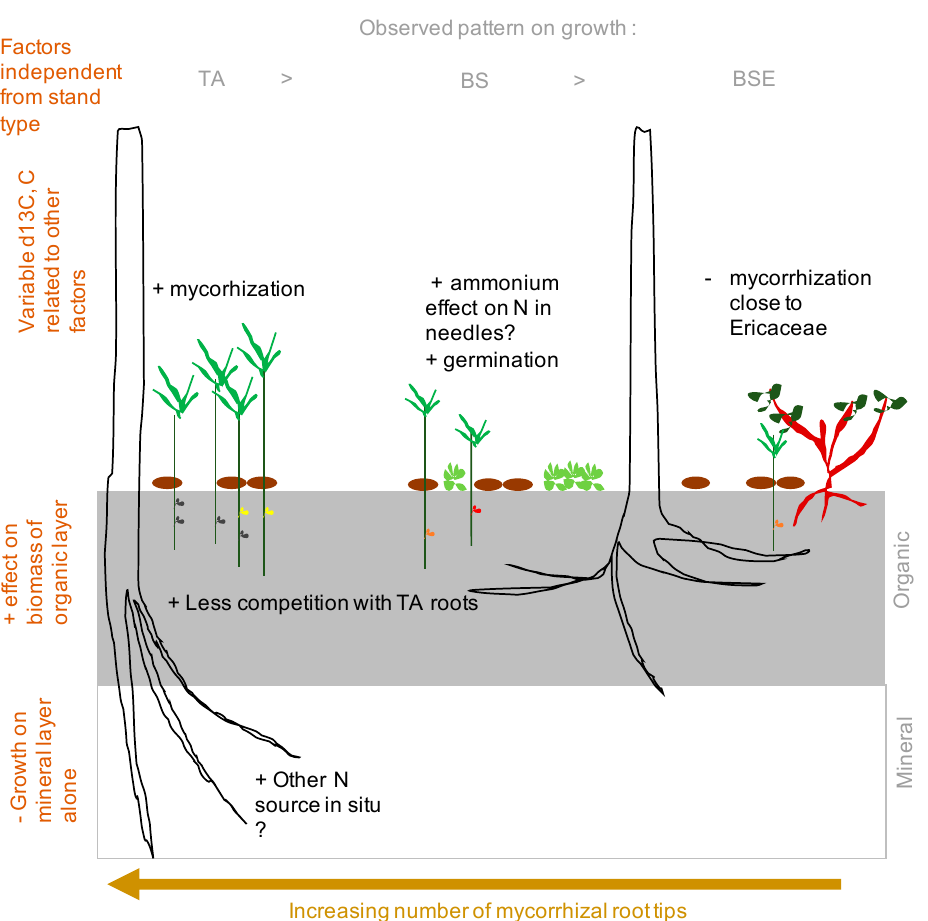
Figure 7. Synthetic summary of positive and negative effect of soil layer, stand, trees, and fungi based on ex-situ and in-situ observations.